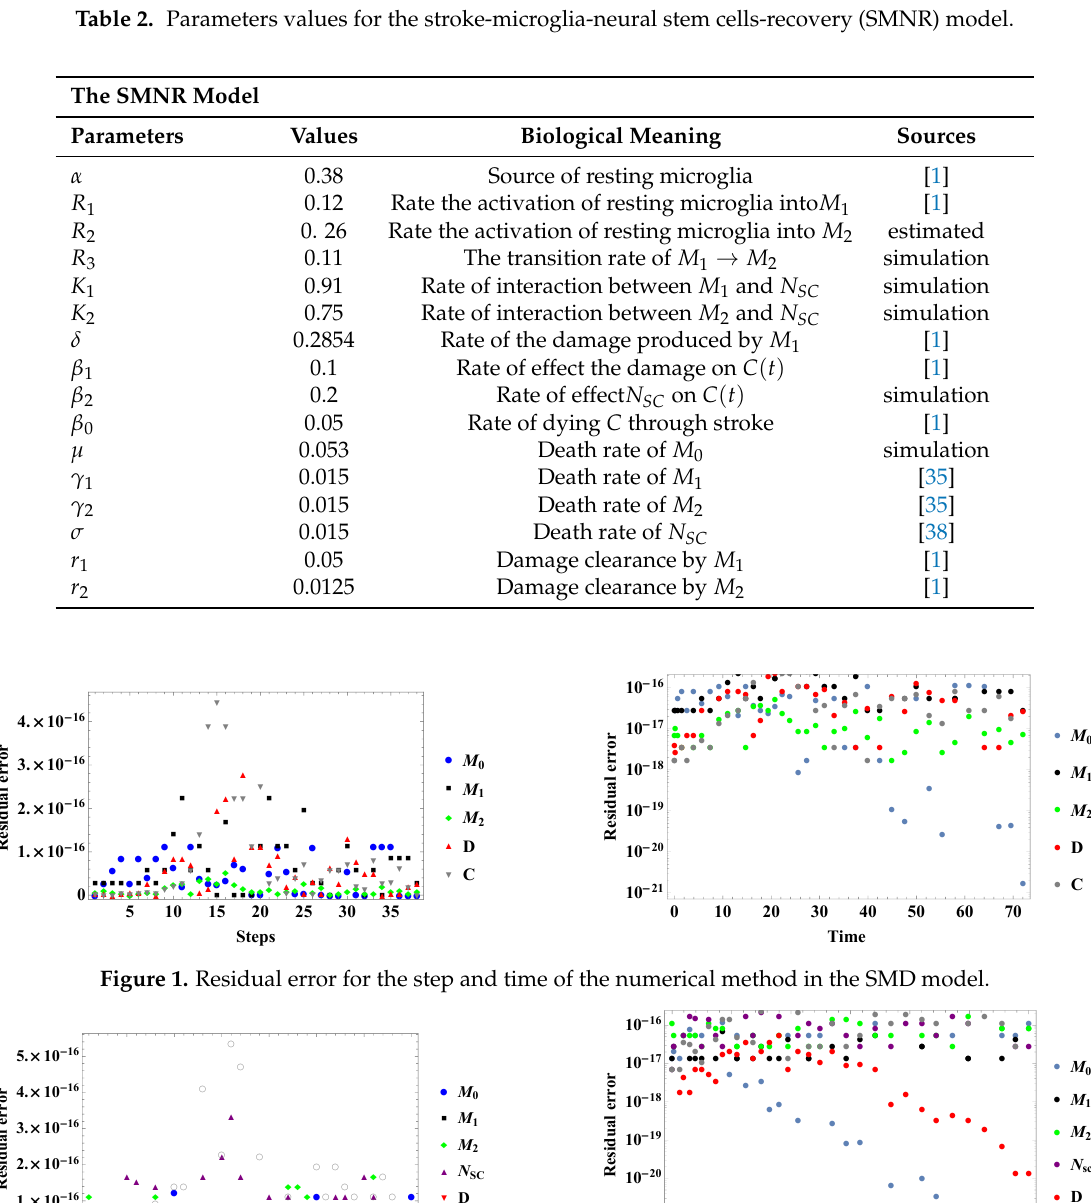
Table 2. Parameters values for the stroke-microglia-neural stem cells-recovery (SMNR) model.